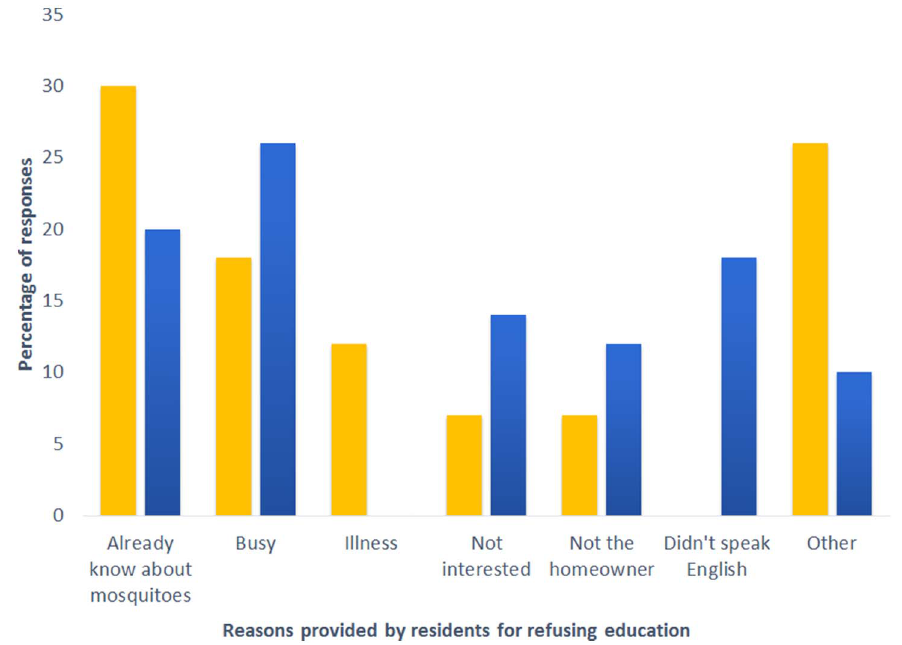
Figure 1. Reasons provided by residents within the educational treatment site for not wanting to be actively educated by the community peer educators. Responses from residents in Monmouth County are represented in yellow, and those from Mercer County are represented in blue.